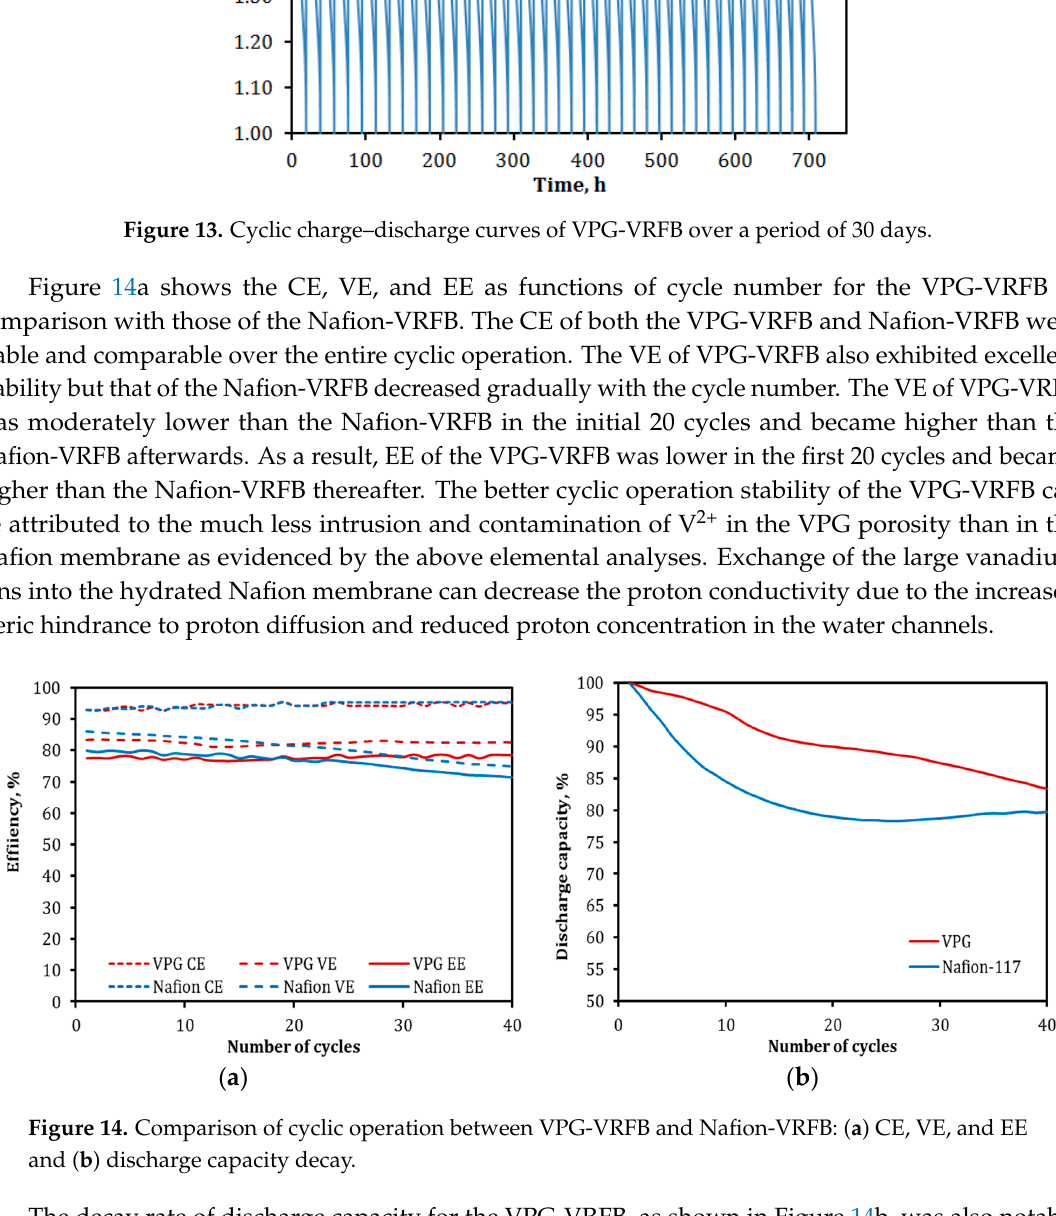
Figure 13. Cyclic charge-discharge curves of VPG-VRFB over a period of 30 days.